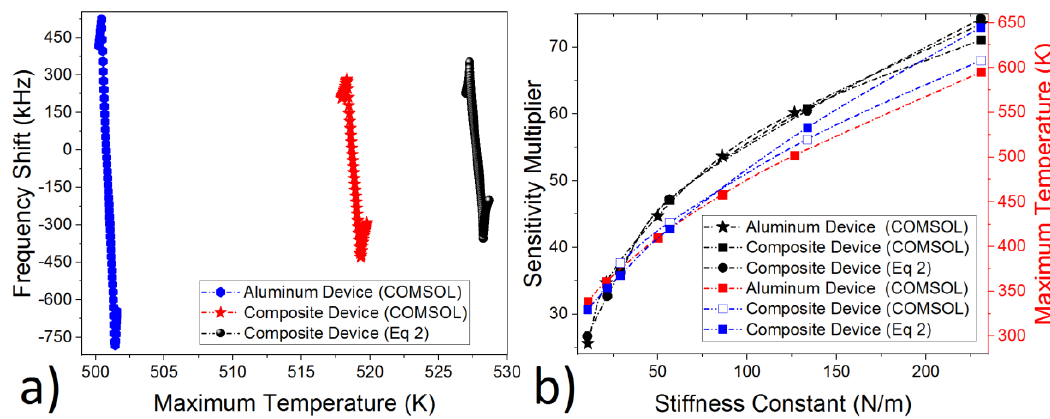
Figure 3. ( a ) Frequency shift with respect to temperature and ( b ) the relationship between stiffness constant, sensitivity multiplier, and maximum allowable temperature for both aluminum and composite structure (Figure 1) derived via COMSOL and Equation (2).